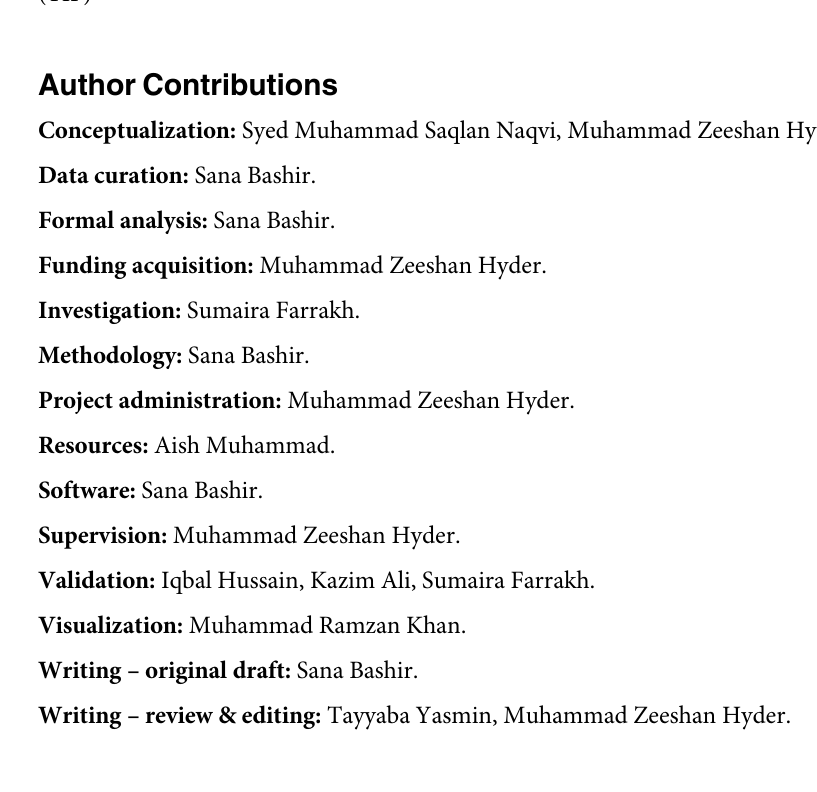
S5 Fig. Phylogenetic analysis of BBTV DNA-N illustrating intra and intergenomic recom- bination events at different